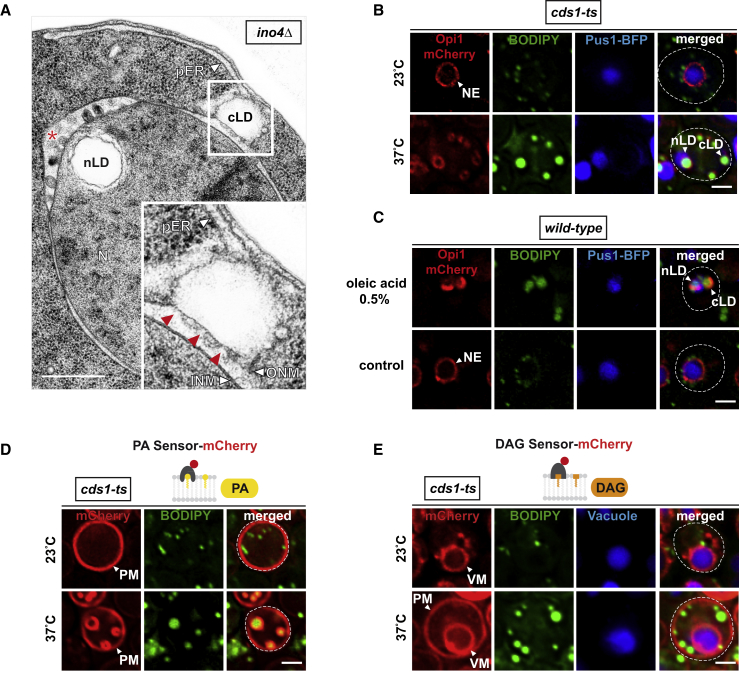
Coordinated Production and Size Control of Nuclear and Cytoplasmic Lipid Droplets(A) TEM analysis of an ino4Δ cell shows an nLD and a cLD. Inset shows magnified view of the boxed area with cLD connections to both ONM and pER. Multiple membrane contacts (red arrowheads) between the cLD and ONM are apparent. INM evaginations are labeled with red asterisk. Scale bar, 0.5 μm.(B) Live imaging of cds1-ts cells expressing Opi1-mCherry and the nucleoplasmic marker Pus1-BFP. Lipid droplets are stained with BODIPY. Cells were grown for 4 hr at the indicated temperatures. Scale bar, 2 μm.(C) Live imaging of Opi1-mCherry expressed in opi1Δ cells. Lipid droplets were stained with BODIPY. Cells were grown in oleic-acid-containing or control media. Scale bar, 2 μm.(D) Live imaging of cds1-ts cells expressing the PA-mCherry sensor. Lipid droplets were stained with BODIPY. Cells were grown for 4 hr at the indicated temperatures. Scale bar, 2 μm.(E) Live imaging of cds1-ts cells expressing the DAG-mCherry sensor. Lipid droplets were stained with BODIPY, vacuoles with CellTracker Blue. Cells were grown for 4 hr at the indicated temperatures. Note that upon Cds1 inhibition the sensor also uncovered a DAG pool at the plasma membrane (PM). VM, vacuolar membrane. Scale bar, 2 μm.See also Figure S7.